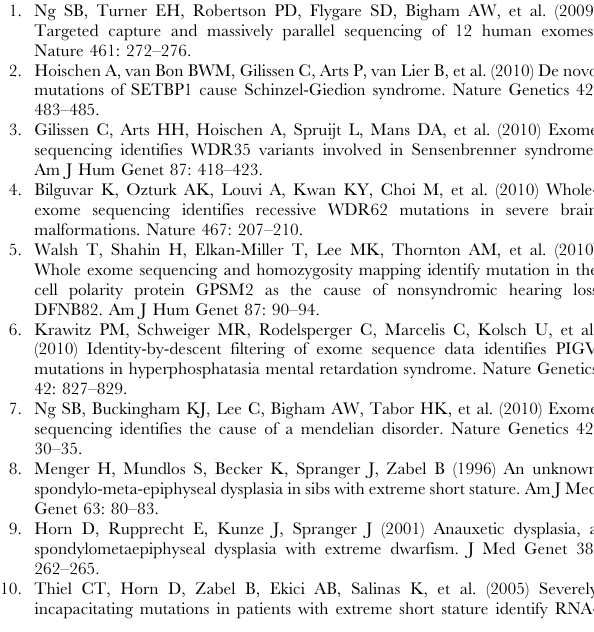
Figure S1 Structure of the RNase MRP complex (modified from Welting et al, reproduced with permission of the Oxford University Press). Human POP1 (hPOP1) highlighted in orange. Domains of RMRP RNA that have been implicated in anauxetic dysplasia highlighted in blue. Table S1 Candidate mutations fitting compound heterozygous model. SKDP 6.1 is the father, SKDP the mother, and SKDP 6.3 and 6.4 the affected